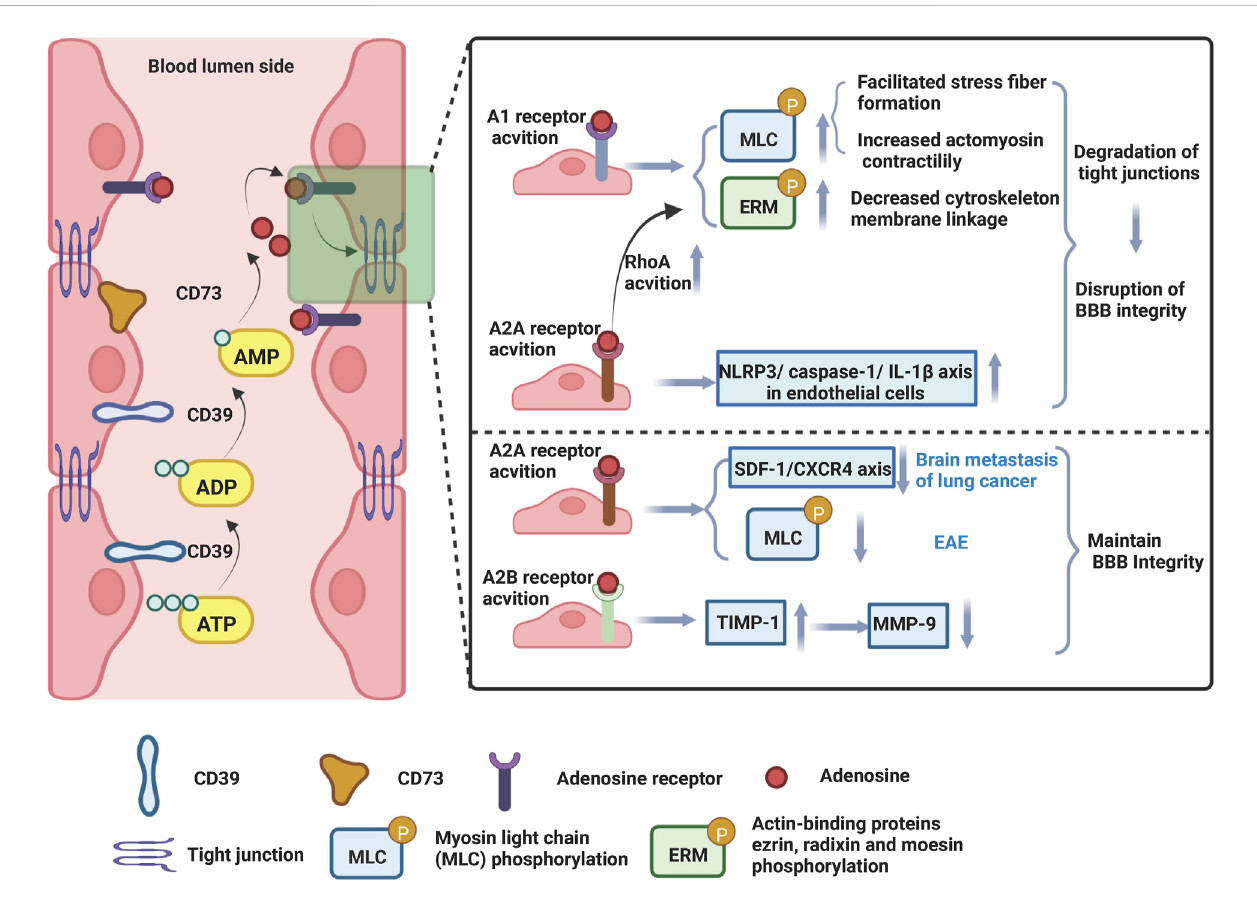
FIGURE 4 Adenosine receptors (ARs) modulate the permeability of blood-brain barrier. Endothelial cells of the microvasculature of the brain express adenosine receptors, CD39, and CD73. Under conditions of tissue damage, stress, and in fl ammation, ATP is released and converted by CD39 into ADP and AMP, which are then converted to adenosine by CD73. Adenosine binds to adenosine receptors on endothelial cells and operates to restructure the actin cytoskeleton, thereby disrupting tight junctions and adherens junctions and affecting BBB integrity. Created with